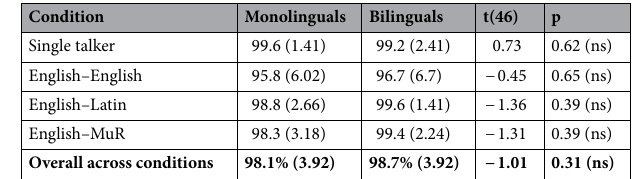
Table 2. Comprehension scores and standard deviation by condition and group.